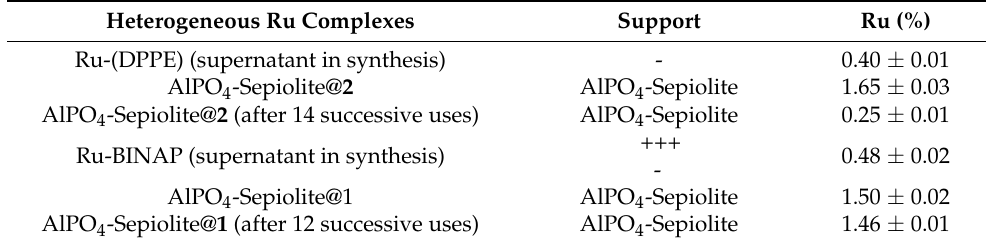
Table 2. Relative amounts of supported Ru (wt.%) in the heterogenized complexes obtained from ICP-AES, after and before being used. The Ru contents that remain in the supernatant solution after synthesis of the immobilized complexes, are also collected. These amounts come from 0.200 g (800 mmol) of RuCl 3 · 4H 2 O, covalently supported on 4 g of AlPO 4 -Sepiolite.